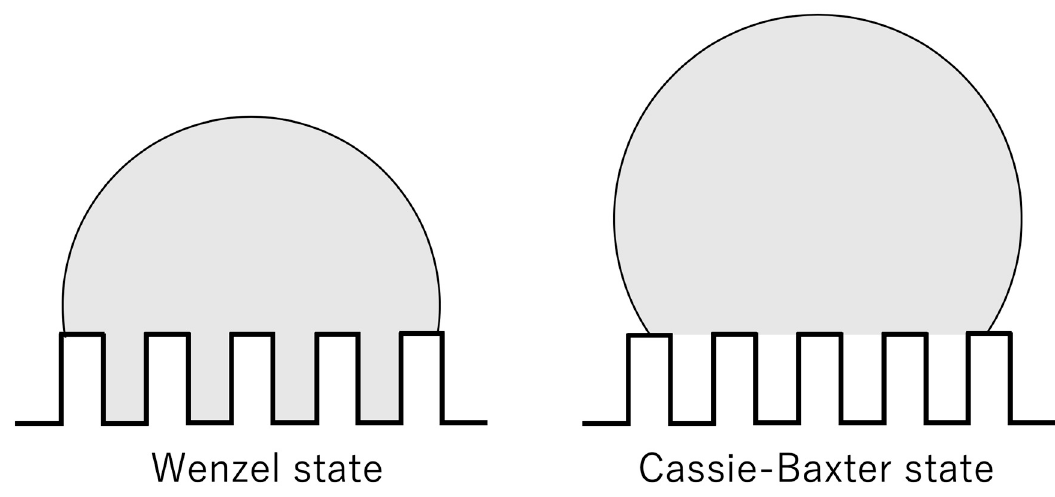
Figure 1. Schematic diagrams of Wenzel state and Cassie-Baxter state.